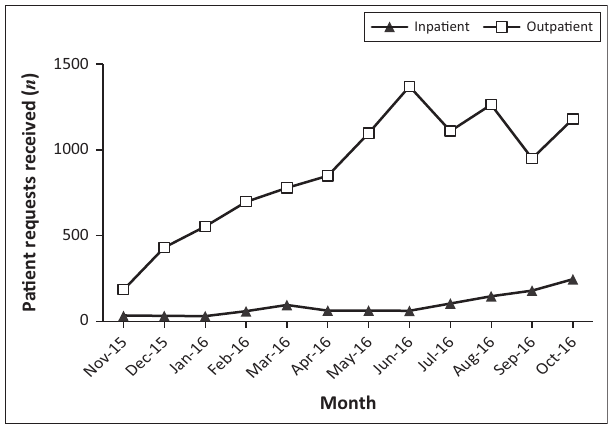
FIG URE 1: Patient request volume by month, Koidu Government Hospital central laboratory, Sierra Leone, November 2015–2016. Individual patient test requests per month separated for inpatient (black triangles) and outpatient (open squares) departments.